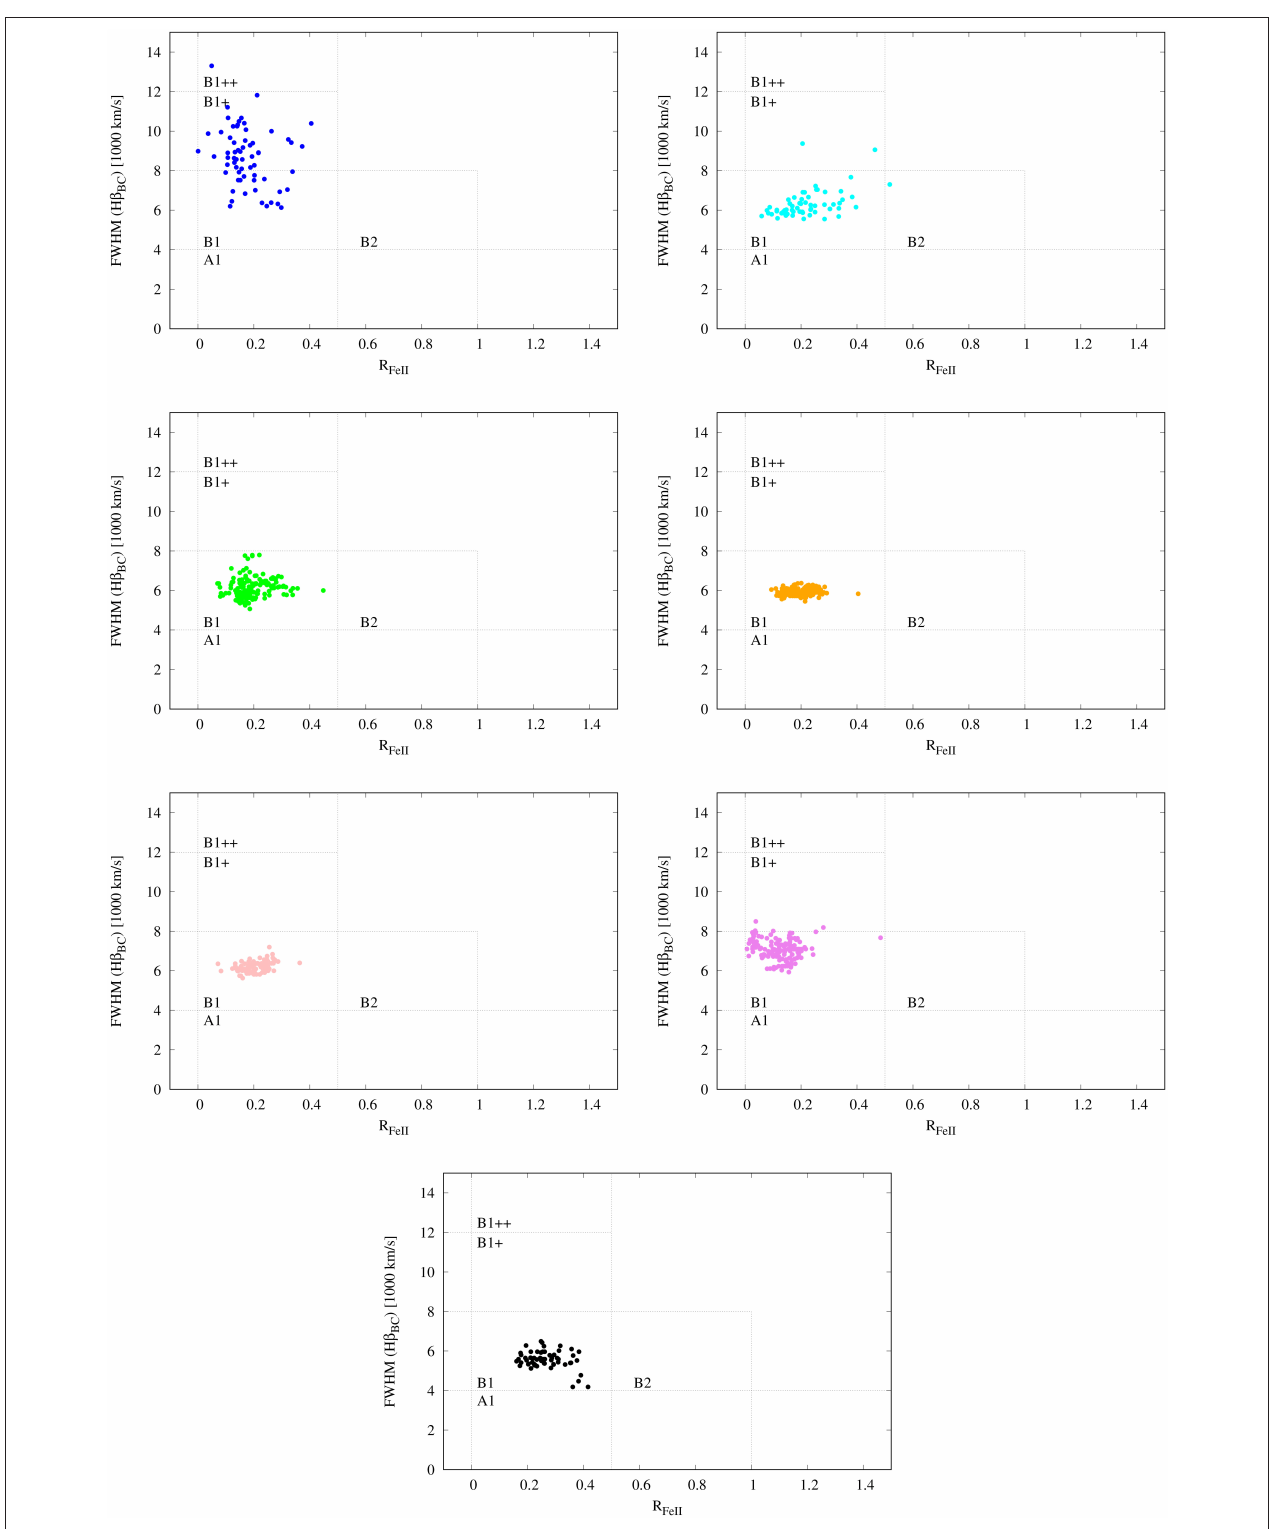
FIGURE 3 | The EV1 diagram of NGC 5548 spectral properties for different time intervals. Colors correspond to those in the Figure 1 .